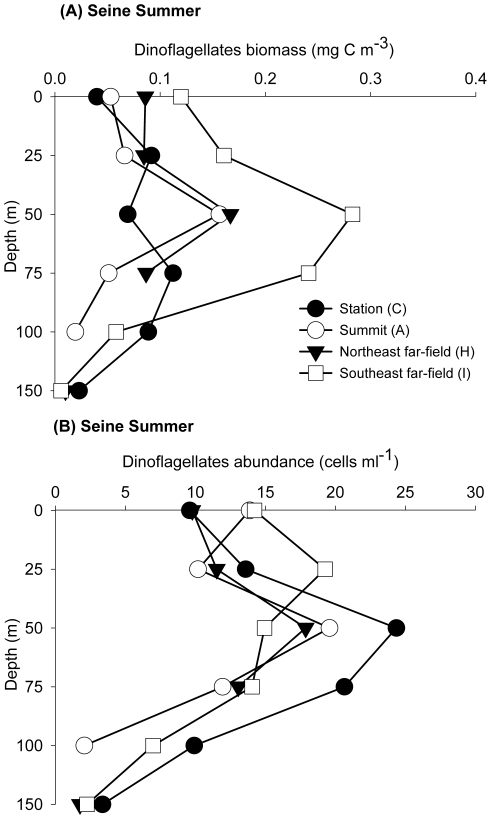
Intra-seamount variability in Seine.Variability in (A) dinoflagellates biomass (mg C m−3) and (B) abundance (cells ml−1) during July 2004. Comparisons are made between the summit station (“A”), a seamount station at the east margin (“C”) and the northeast and southeast far-field stations “H” and “I”, respectively.